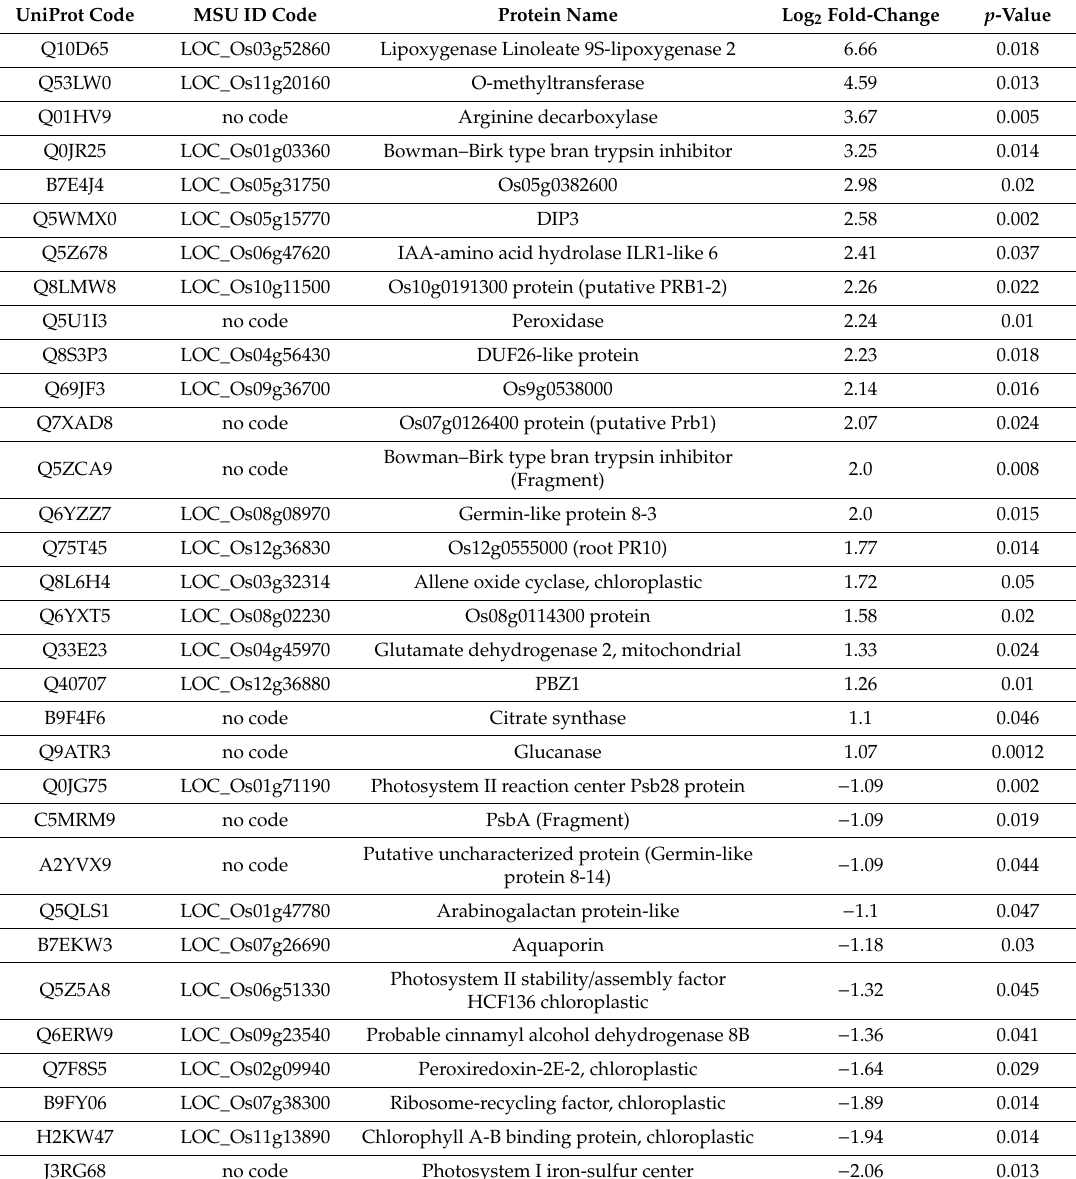
Table 1. Di ff erentially expressed proteins (DEPs) after MeJA treatment (P), compared to mock (M). UniProt